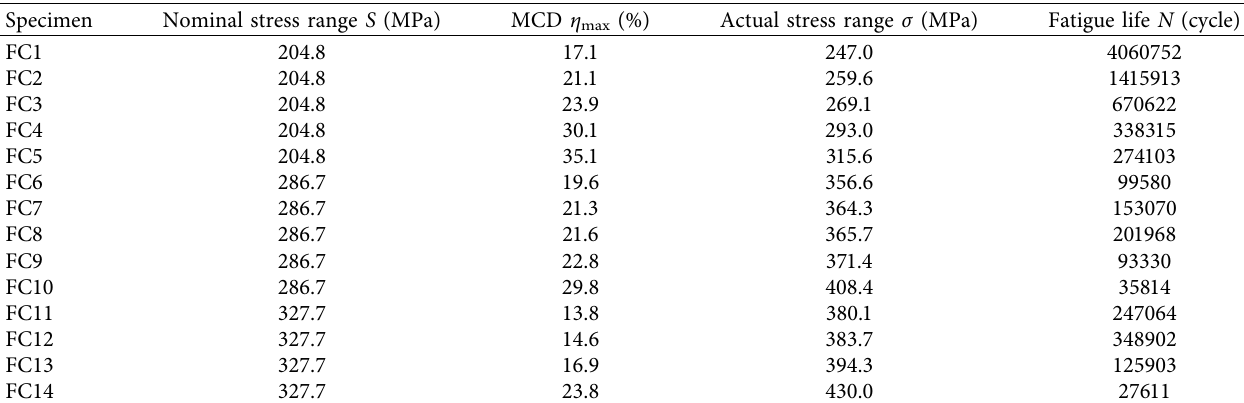
Figure 5: 3D surface profile measurements and pit geometry of the specimen FC3. Table 3: Fatigue testing results of corroded